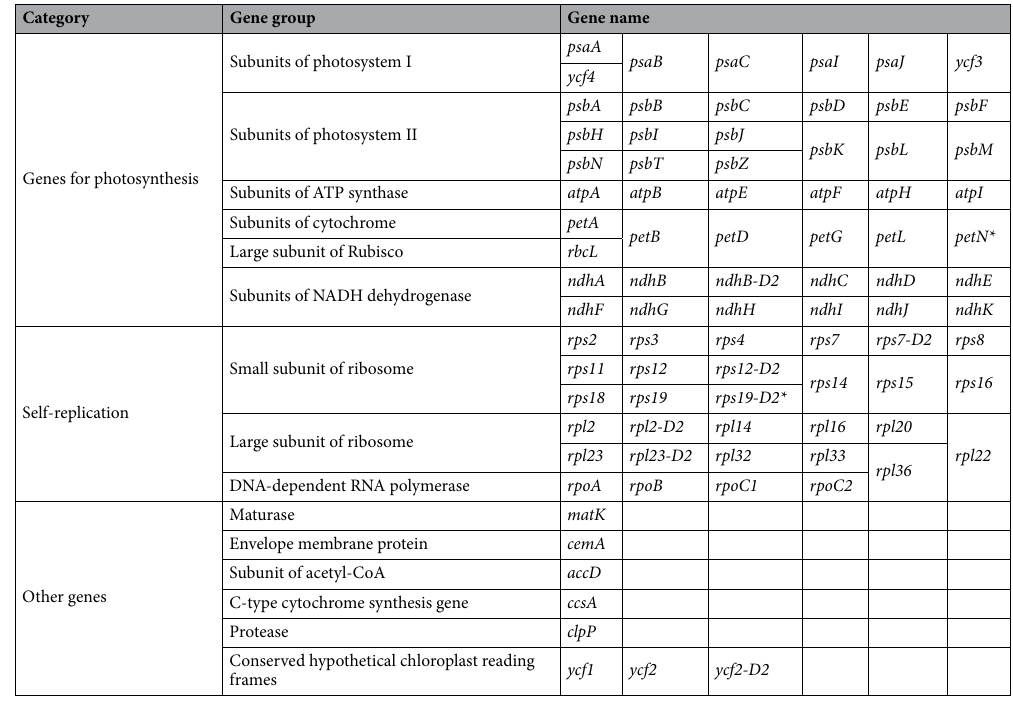
Table 1. List of protein-coding genes present in Hibiscus cannabinus. L (P3B) chloroplast genome. “*”represented genes were absent in cp genome of